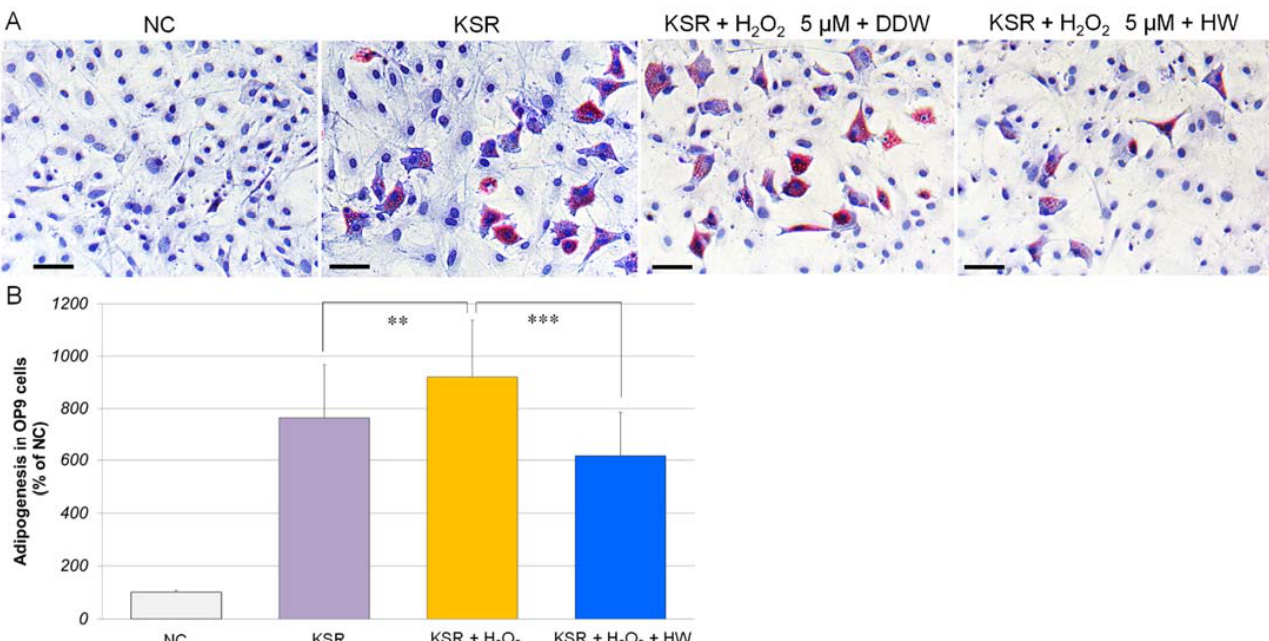
Figure 4. Repressive effects of HW on hydrogen-peroxide-stimulated adipogenesis in OP9 cells. OP9 preadipocytes (30,000 cells/well) were seeded into 24-well plates and grew to 100% confluence in the maintenance medium. Cells were then cultivated in DDW- or HW-prepared KSR medium with or without H 2 O 2 for 4 days. The negative control (NC) cells were cultivated in the maintenance medium. At the end of cultivation, cells were fixed with 10% formalin. Cellular lipid droplets were stained with Oil Red O dye. The intracellular dye was extracted and transferred to a 96-well plate, and quantified in a microplate reader at 520 nm. ( A ) Typical images of Oil Red O staining. Blue, nuclei; red, lipid droplets. Scale bar = 25 µm. ( B ) Data are expressed as a percentage of the negative control, and each concentration point and bar represent the mean ± SD of five independent experiments. ** p < 0.01; *** p < 0.001.